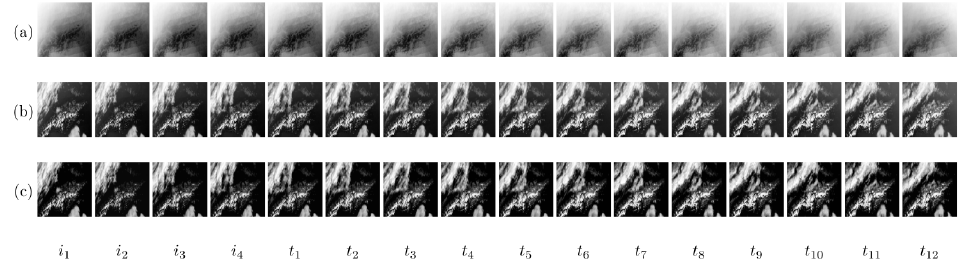
Figure A1. Example 4 h sequence from the training dataset showing direct surface solar irradiance extracted from the MSG-CPP dataset assuming clear sky ( a ), and without assuming clear sky ( b ), with ( c ) showing the normalised solar radiation used as a proxy for cloudiness (with values between 0 and 1). Darker regions show higher solar radiation while lighter regions represent lower solar radiation. i n represent the input frames used to train the models, while t n represent the target